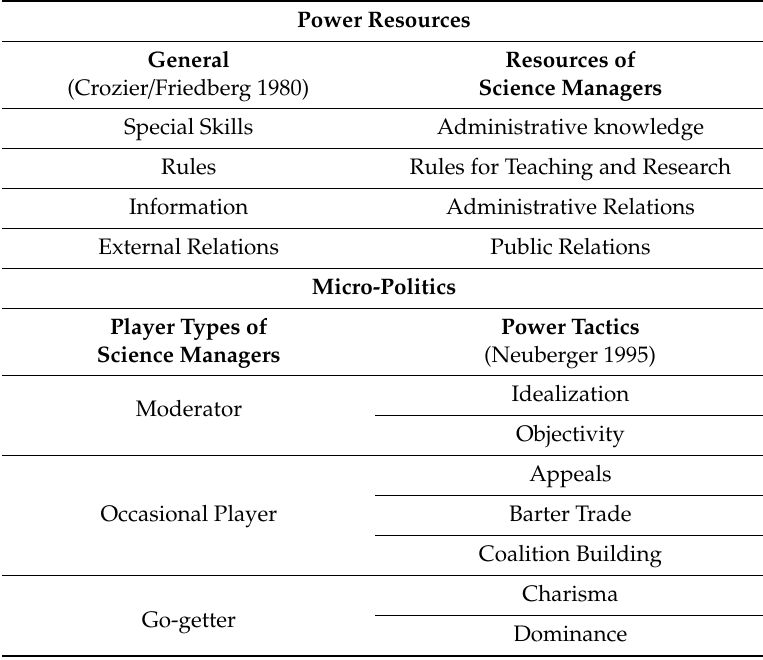
Table 2. Summary of the model for power relations of science